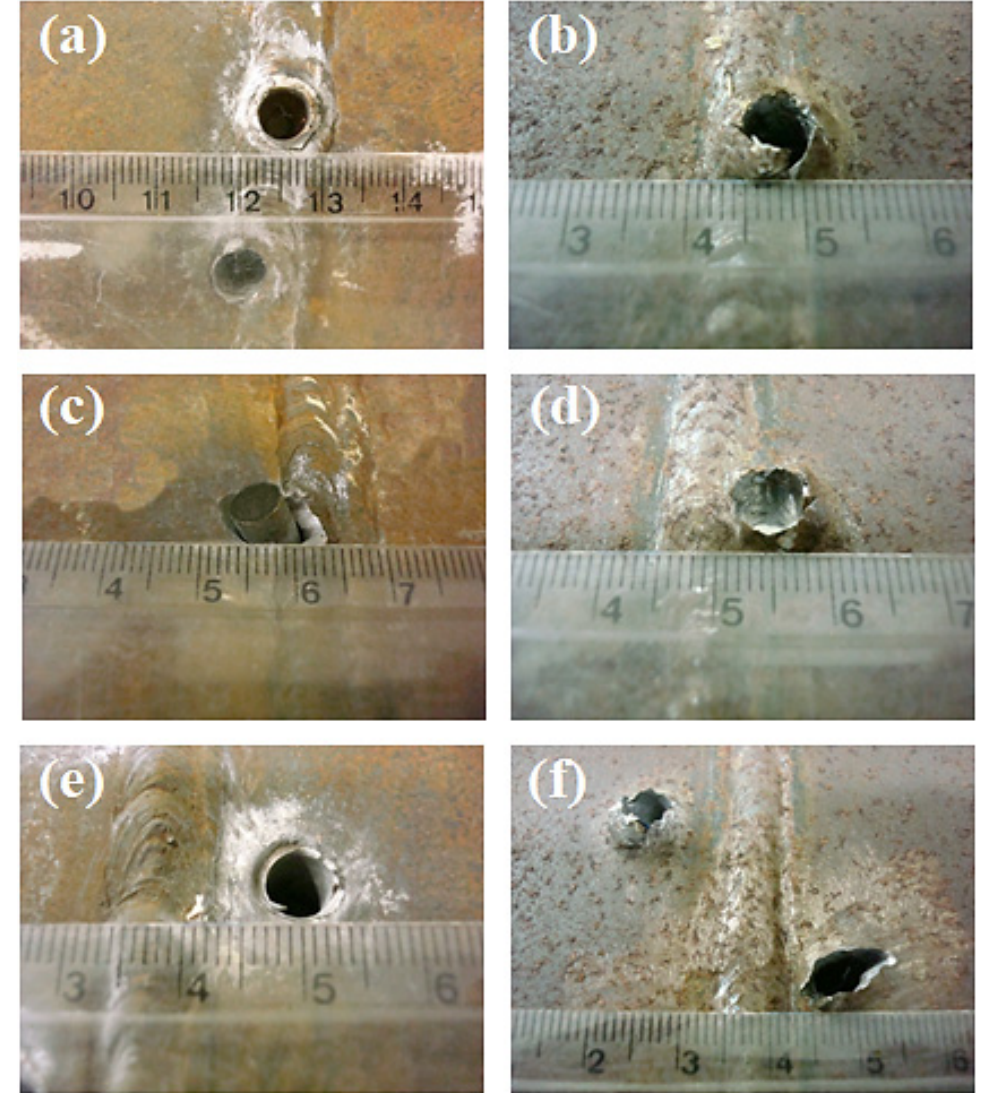
Figure 14. Ballistic damage at LHI weldment from 7.62 mm projectile impact with velocity higher than V 50 : ( a ) frontal hole in FZ; ( b ) distal hole in FZ; ( c ) frontal hole in HAZ; ( d ) distal hole in HAZ; ( e ) frontal hole in BM; and ( f ) distal hole in BM. (Ruler small divisions in mm).